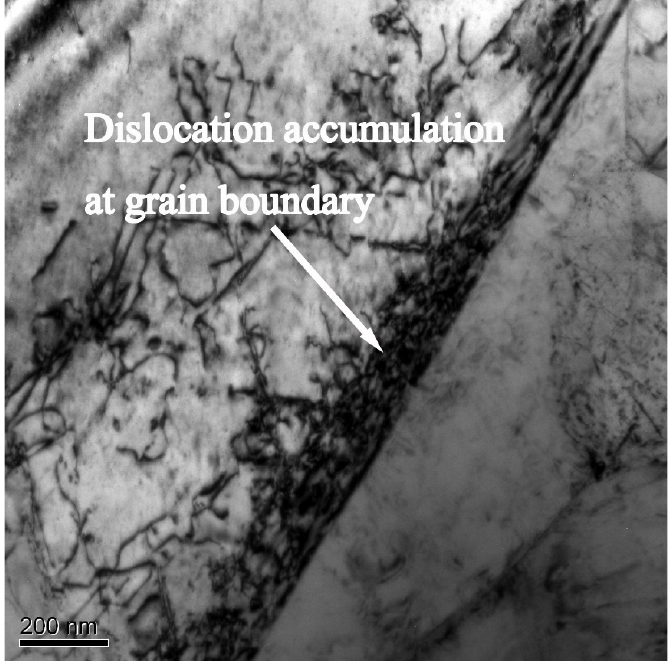
Figure 16. TEM image of specimen deformed at 960 ° C.